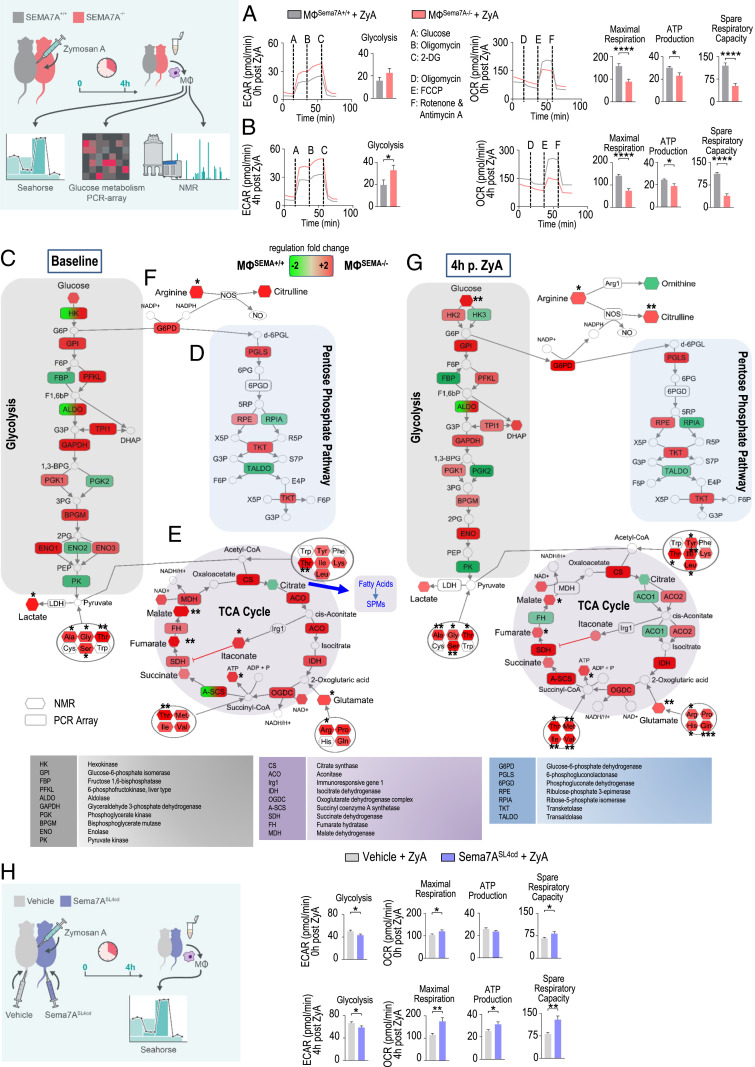
Sema7A drives cellular metabolism. Glycolytic capacity and mitochondrial respiration were assessed by using the Seahorse Glycolysis and Mito Stress tests. MФsSEMA7A+/+ and MФsSEMA7A−/− were subjected to peritoneal lavage, and ECARs were measured after consecutive injections of glucose, oligomycin, and 2-DG. Oxygen consumption rates were determined after injections of oligomycin, FCCP, rotenone, and antimycin A. Glycolytic and mitochondrial respiration markers were calculated (A) at baseline and (B) following stimulation with ZyA for 4 h (n = 20). The glucose metabolism pathways in MФsSEMA7A+/+ and MФsSEMA7A−/− were assessed via the PCR-based analysis of enzymes involved in glucose metabolism. Intracellular metabolites were quantified by NMR spectroscopy (n = 3). The experiment was conducted (C–F) at baseline and (G) following stimulation with ZyA for 4 h. (H) ECAR and OCR were also determined in MФs from C57/BL/6 mice that were stimulated either with vehicle (MФvehicle) or the peptide Sema7ASL4cd (MФSEMA7A−SL4cd) followed by ZyA stimulation for 0 and 4 h. Samples were pooled from three to four mice in each group. The results represent three independent experiments and are expressed as the mean ± SEM; significance was determined by the unpaired two-tailed Student’s t test. *P < 0.05; **P < 0.01; ***P < 0.001, ****P < 0.0001.